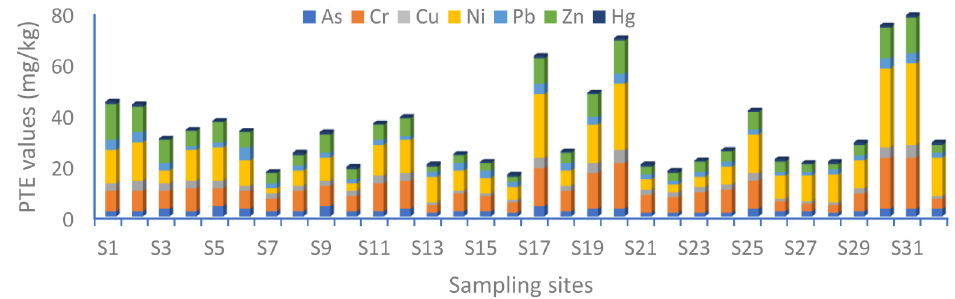
Figure 2. Distribution of the PTEs in the coastal sediment between Al-Jubail and Al-Khafji.